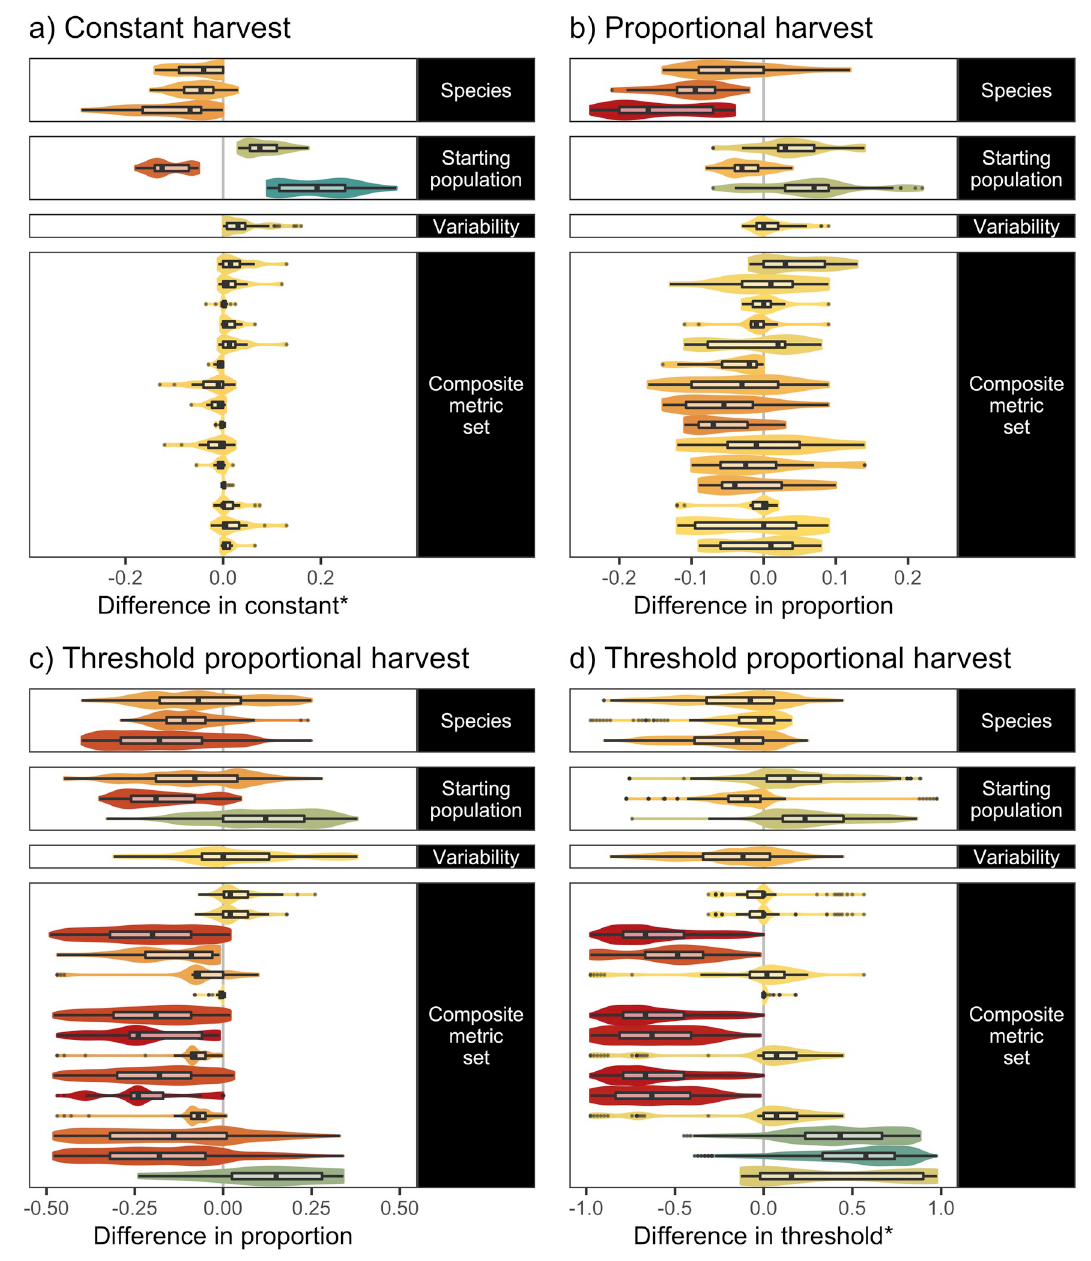
Fig 5. Influence of environmental and evaluation factors on optimal harvest parameters. Thumbnail figure (full figures given in the S2.3 Section in S2 Appendix) showing pairwise differences in optimal harvest parameters (i.e. those parameters giving the highest composite metric scores in each respective context) given environmental and evaluation factor contrasts, for a) constant, b) proportional, and c) and d) threshold proportional harvest strategies (proportion in c) and threshold in d) respectively). For further plot description, including colour legend, see Fig 4. The � indicates that the constant and threshold are scaled by the number of individuals considered as a ‘moderate’ population size for each of the species (i.e Moose = 600, Roe Deer = 6950, Ptarmigan = 17500). This overview figure shows how harvest parameter decisions are influenced relatively more by evaluation contexts in more complex harvest strategies (e.g. threshold proportional), compared with a simple ‘constant harvest’ strategy.